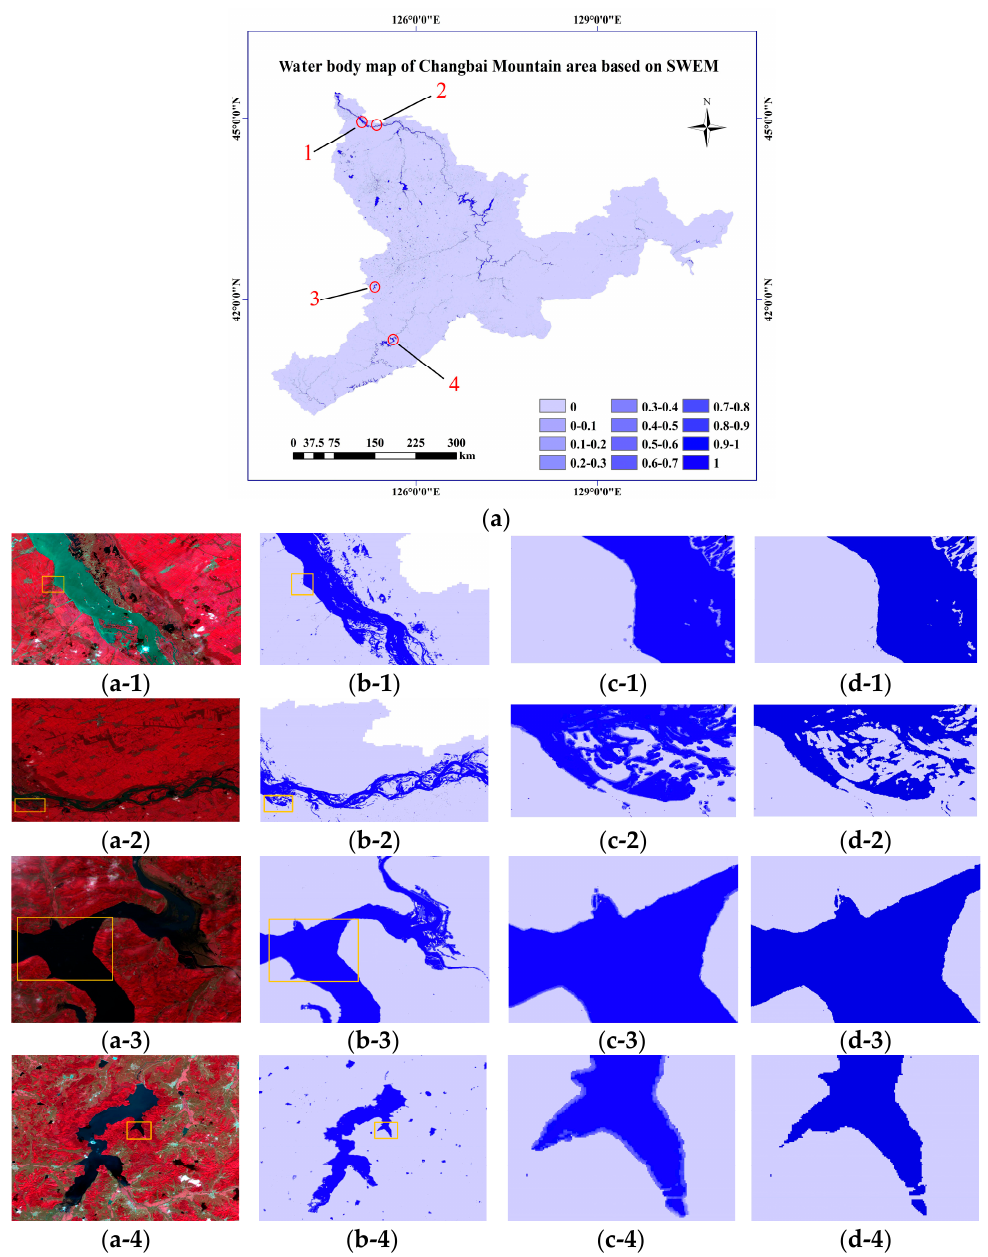
Figure 9. Water map of superpixel decomposition and the results of water decomposition at a larger scale in the Changbai Mountain area. ( a ) Water results using the SWEM. ( a-1 – a-4 ) False color image of circle 1 to circle 4. ( b-1 – b-4 ) Water results using the MDFM and SWEM from circle 1 to circle 4. ( c-1 – c-4 ) Enlarged water results using the MDFM and SWEM from circle 1 to circle 4. ( d-1 – d-4 ) Enlarged water results using the MDFM from circle 1 to circle 4.